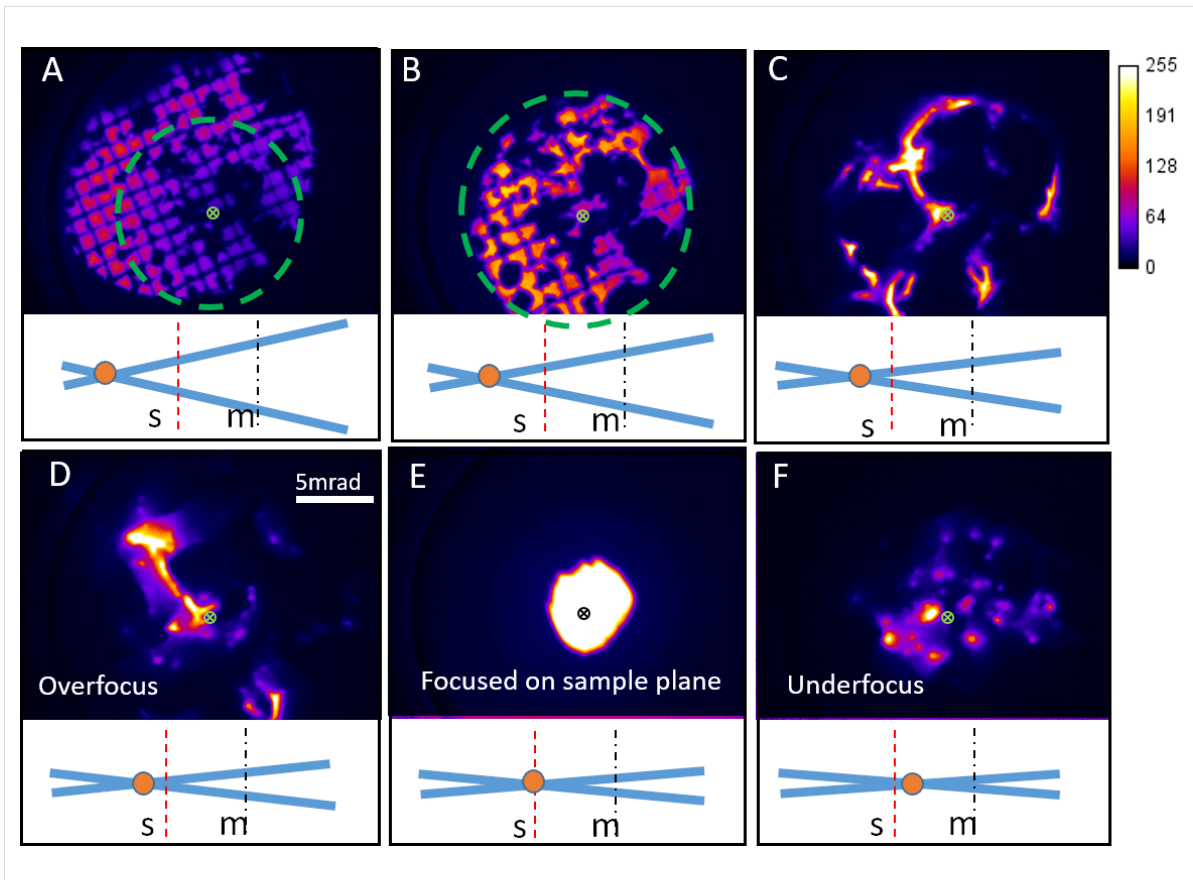
Figure 2: For a BN sample, the voltage of Lens 2 was decreased from (A) to (E). A) A shadow image, B) a higher magnification shadow image of the area highlighted with the green dashed circle in A, C) an even higher magnification and the start of deflection pattern formation with bright outlines, D) the overfocus deflection pattern , E) beam focused on sample plane and F) the underfocus spot pattern. The scale bar in D is 5 mrad (0.39 cm for a sample to MCP separation of 78.5 cm) and applies to all images. (The green or black crosses mark the approximate beam focal point, i.e., the beam axis). The grid window is 108 µm wide with a grid bar width of 19 µm. Underneath each image is a lens diagram showing the position of the Lens 2 focal point cross over (orange circle), the dashed red line is the sample plane (s) and the dot-dashed black line is the MCP plane (m). The color bar shows the grayscale pixel value recorded in the CCD image.